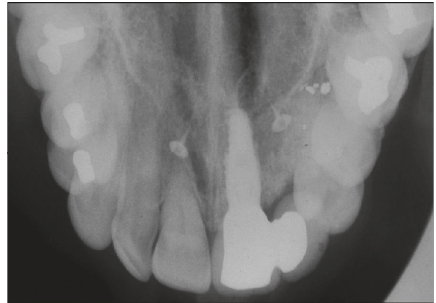
Figure 3: Standard occlusal radiograph taken at initial consultation. The orifices of bilateral nasopalatine canals can be seen clearly apical to the central incisor teeth—the incisive canals: one at the apex of the implant and the other at the apex of natural tooth 11.